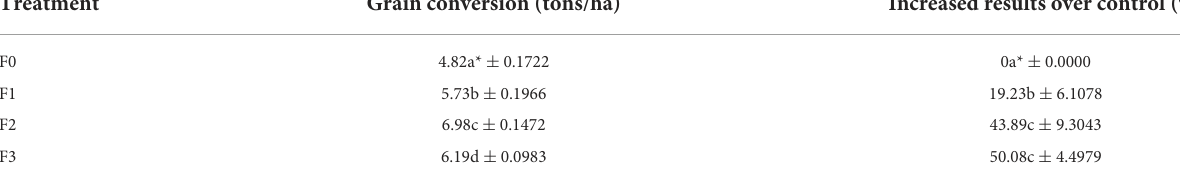
TABLE 4 Grain conversion (tons/ha) and increased results over control in